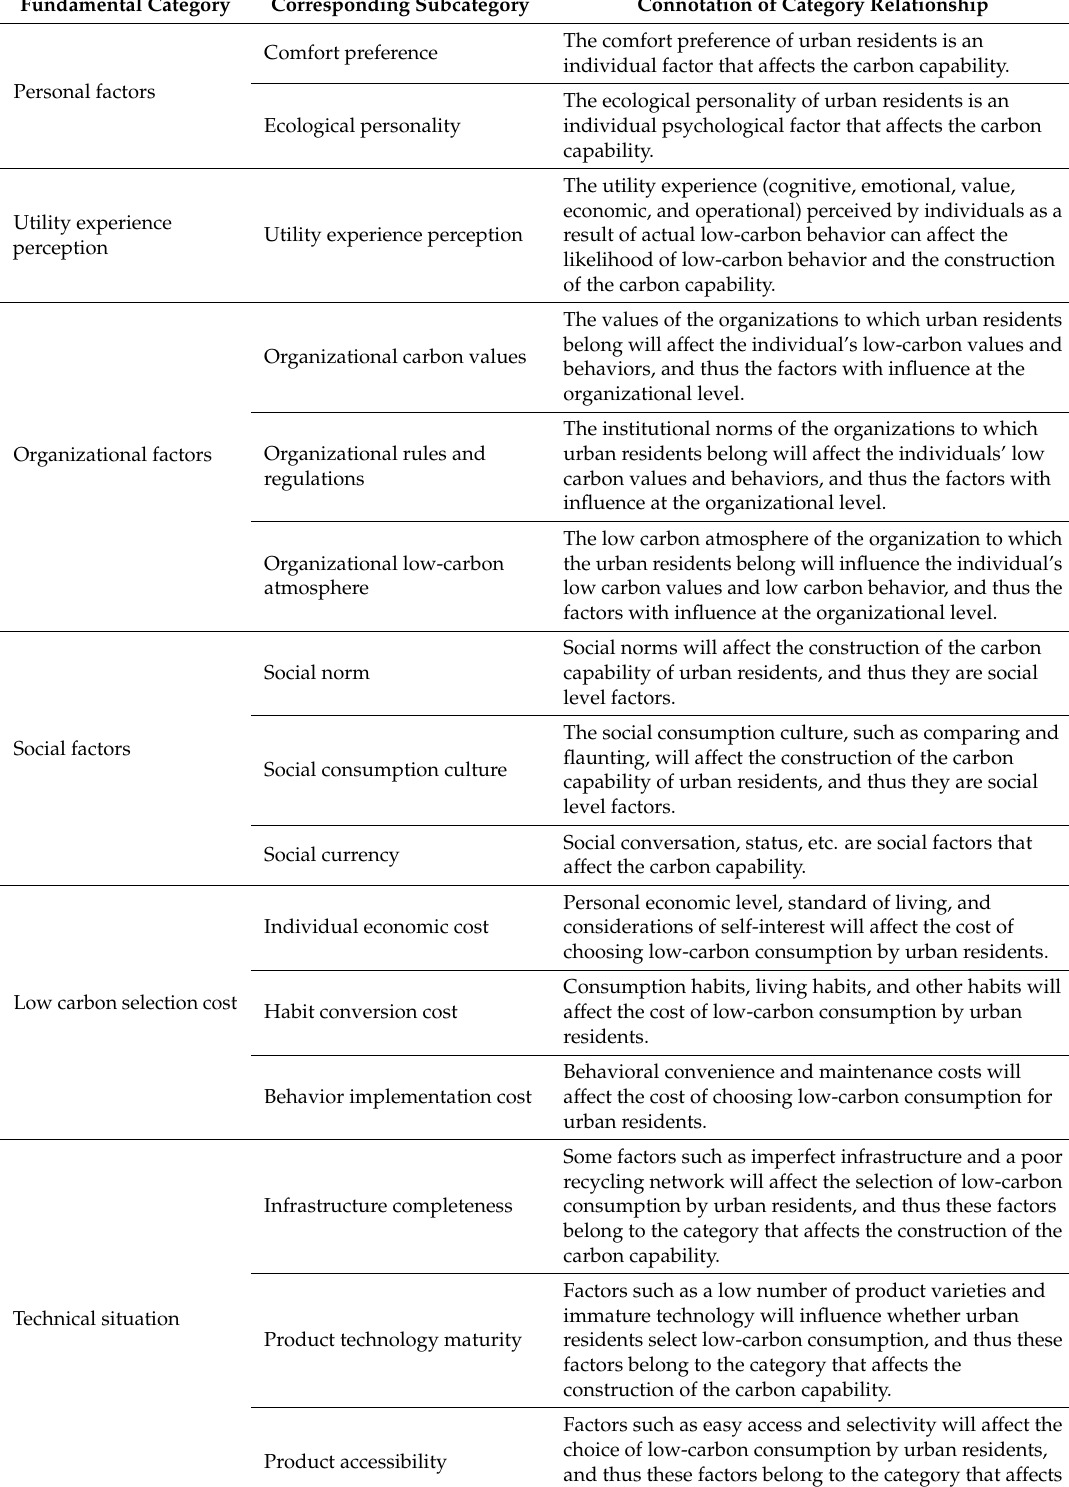
Table 4. Process and results of axial